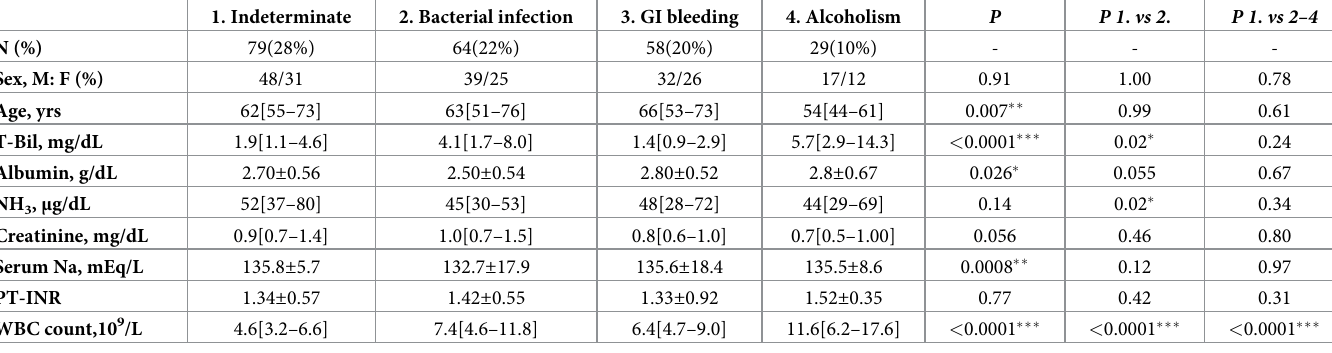
Table 2. Comparison of background parameters according to four principal acute precipitants in AD/ACLF. 1.